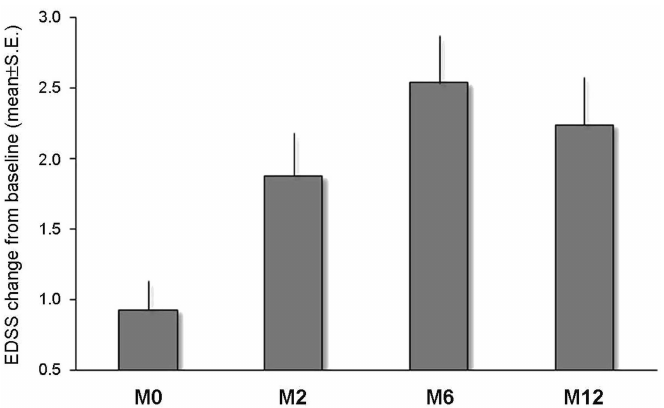
Fig 2. Longitudinal evolution of disability throughout the 12-month observational